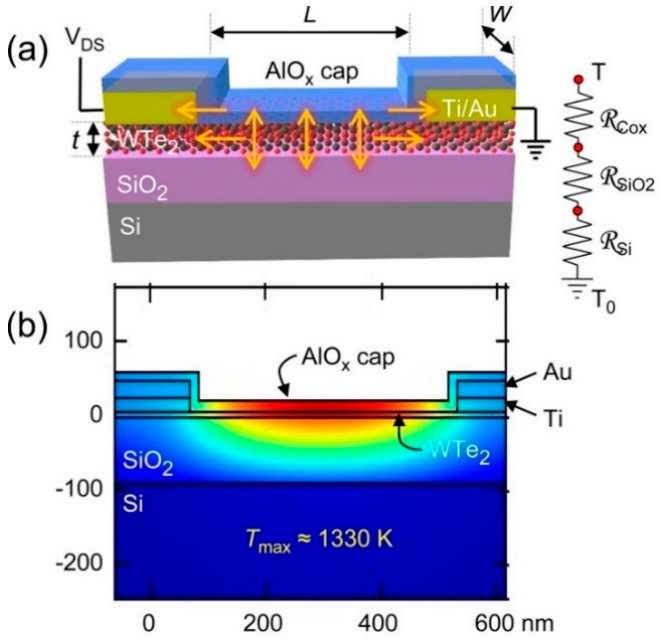
Figure 9. ( a ) Schematic of WTe 2 device in the experiment; ( b ) The simulation of thermal property of WTe 2 before breakdown [7].